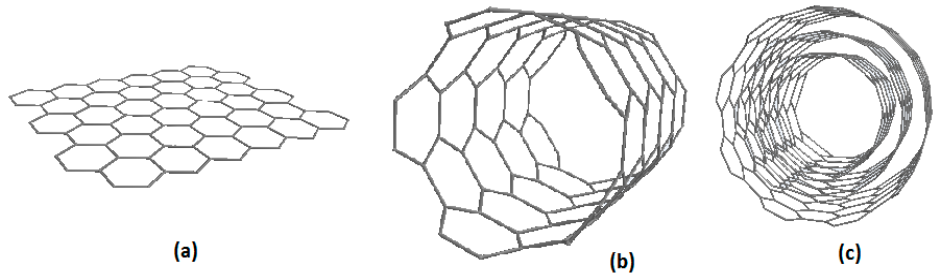
Figure 1. Molecular models of sp 2 -bonded carbon nanostructures: ( a ) graphene clusters, ( b ) single-walled carbon nanotubes (SWCNTs), ( c ) multiwalled carbon nanotubes (MWCNTs) formed from continuous concentric graphene tubes.